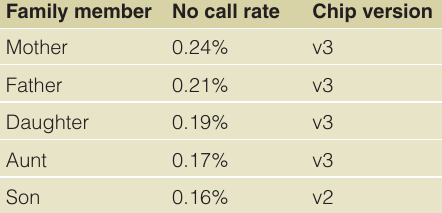
Table 1. Summary of reported no-call rates for all 23andMe chips included in this